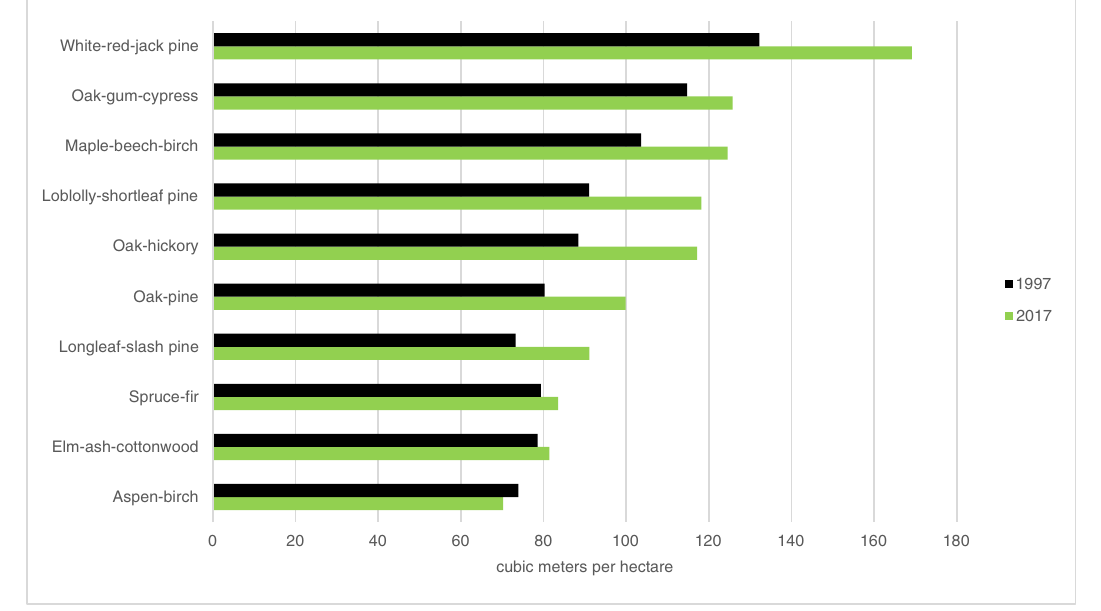
Fig. 1 | Wood volume per hectare in 1997 and 2017 separated by forest group. Source: USFS 1997 and 2017 RPAs 5,6